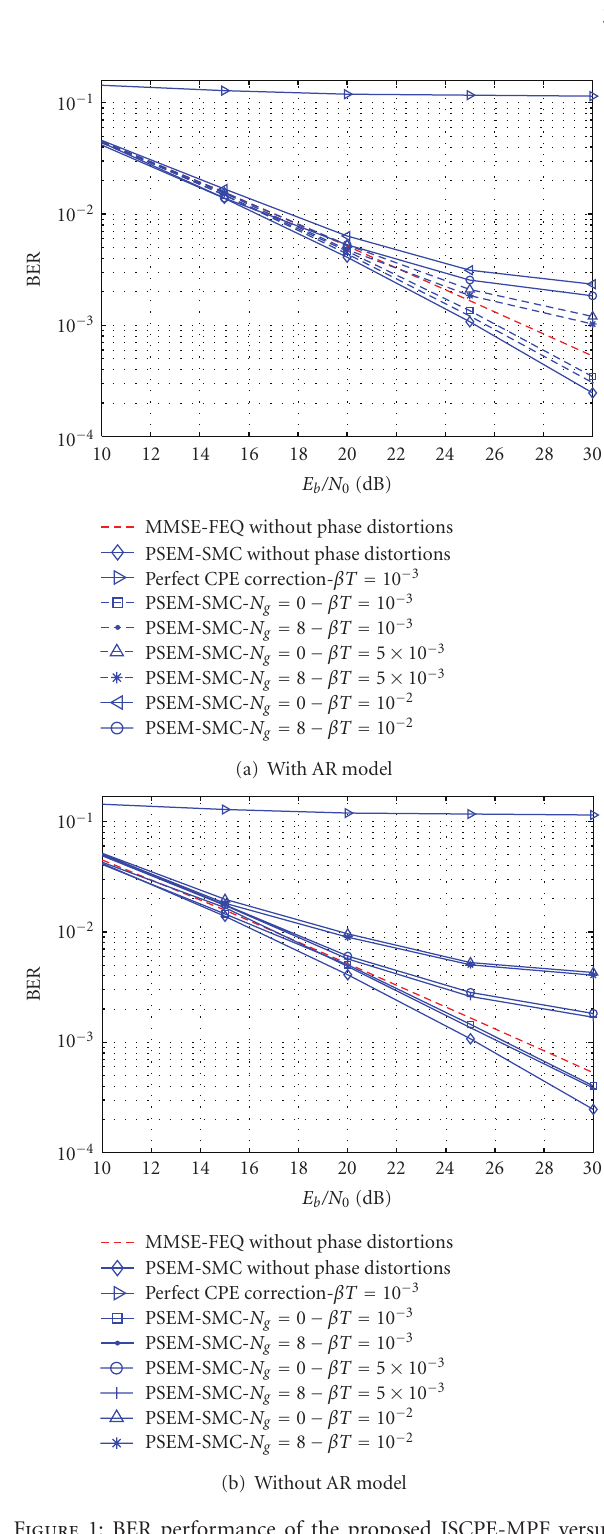
Figure 1: BER performance of the proposed JSCPE-MPF versus E b /N 0 for di ff erent PHN rates βT and numbers of null subcarriers ( P = 4, (cid:2) = 0 .